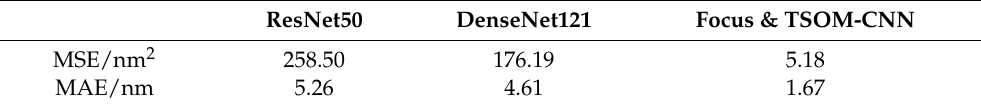
Table 1. The performance summary of other TSOM methods and Focus & TSOM-CNN.